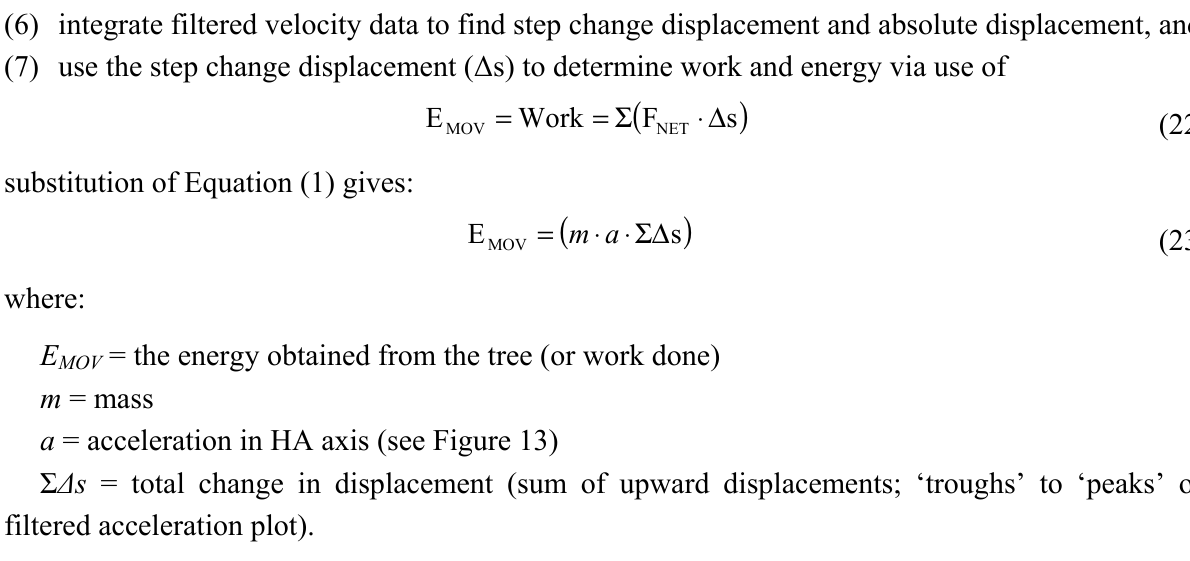
Figure 13. Theoretical arrangement of inertial harvester used for tree acceleration